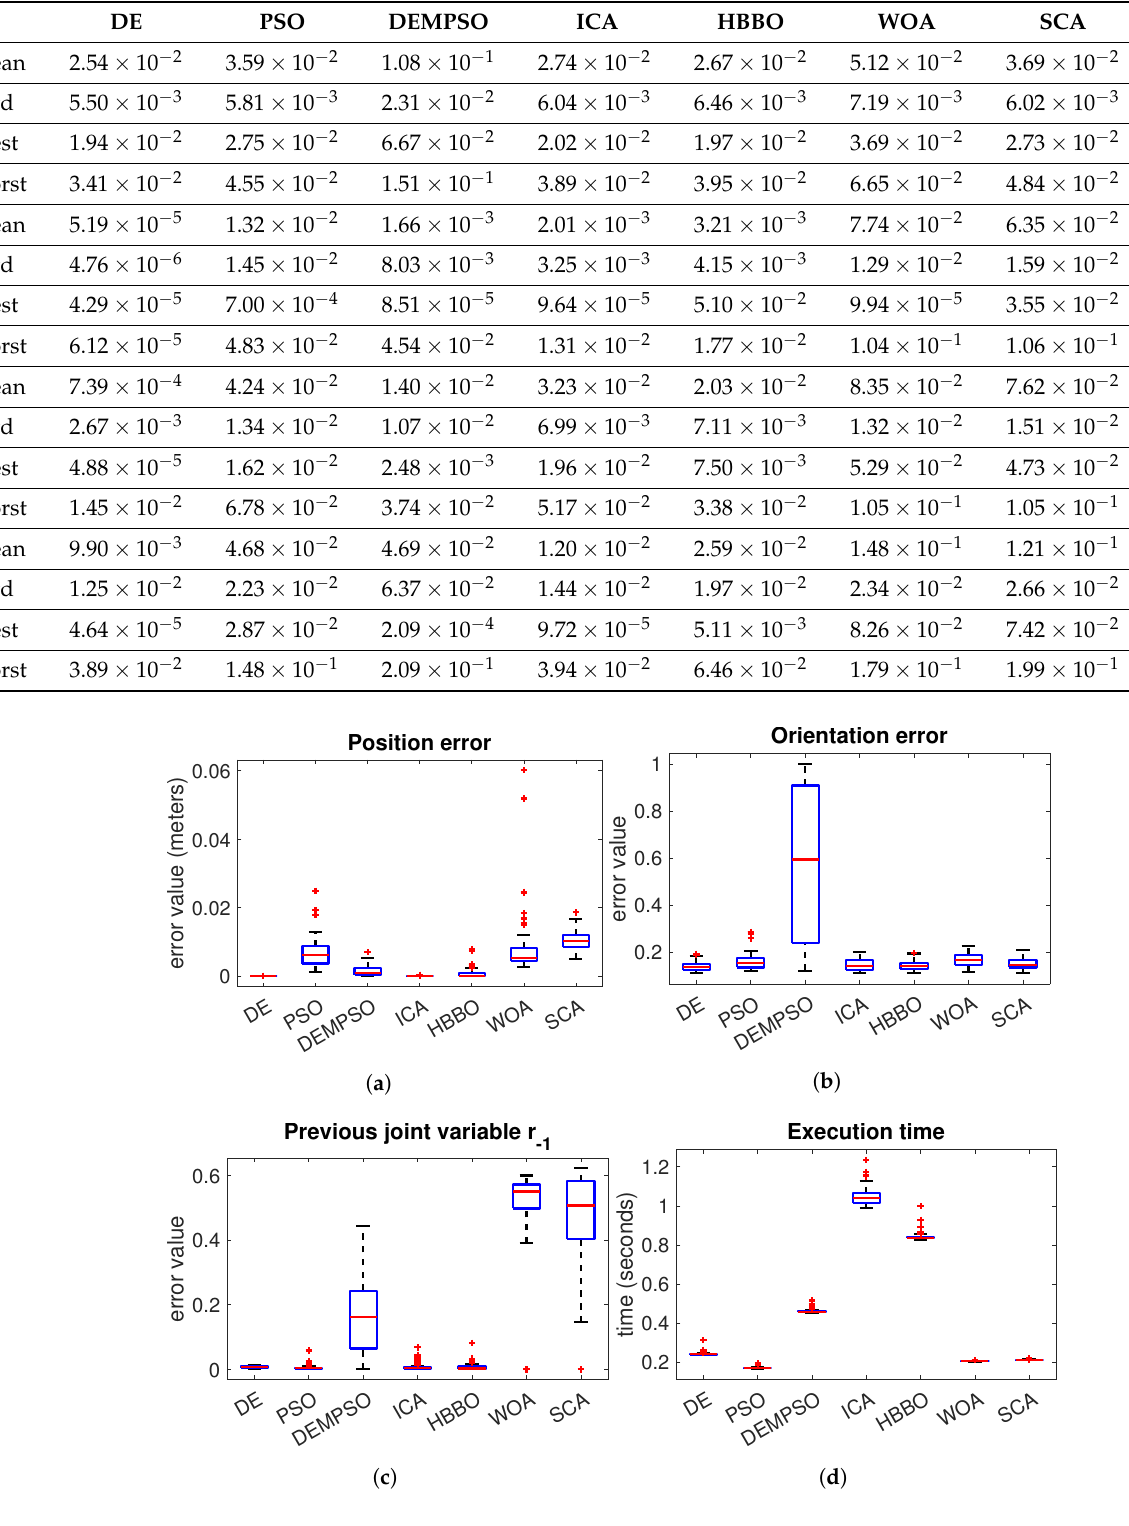
Figure 8. Lemniscate path tracking results for the Youbot robot. ( a ) Youbot end-effector position error (5); ( b ) Youbot end-effector orientation error (15); ( c ) Youbot joint variables error (16); ( d ) Execution time for each point in the